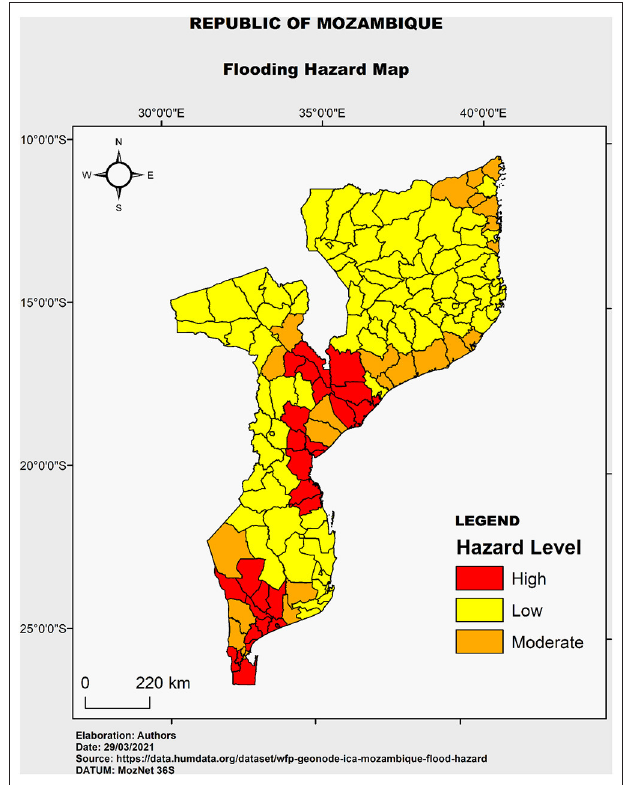
FIGURE 5 | Flooding hazard map. Source: Author.